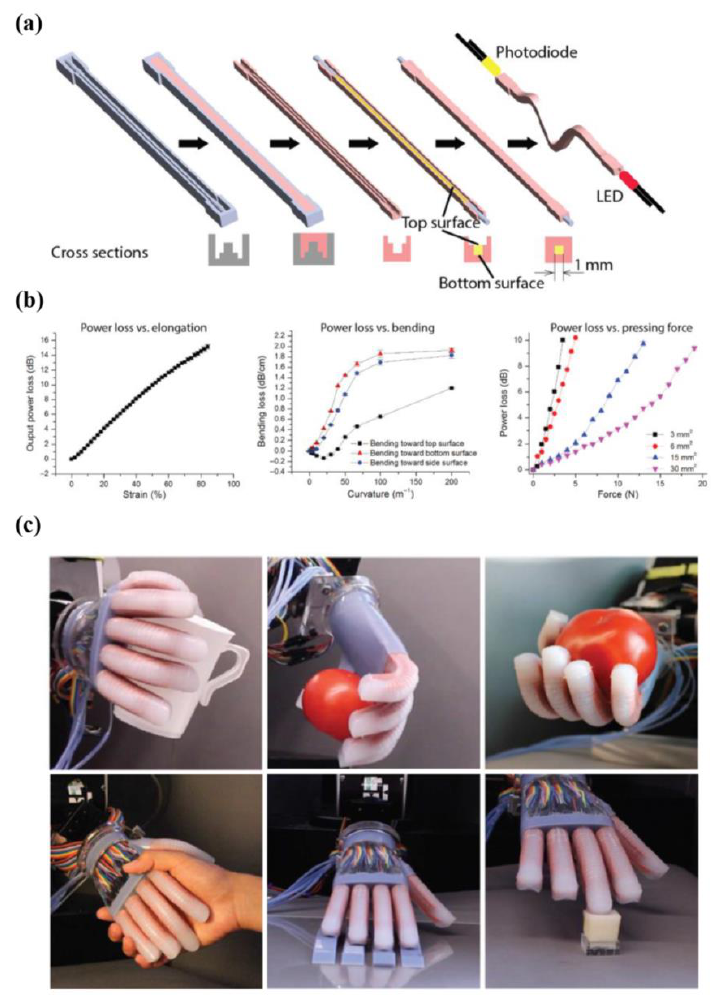
Figure 17. ( a ) Schematic illustration explaining fabrication process of the waveguide; ( b ) output data showing the sensing capabilities of waveguide sensor with respect to different situations including elongation, bending, and pressing force; ( c ) sensing abilities of the device related to the various motions (reprinted with permission for Figure 17a–c from Ref. [142] Copyright 2016 The American Association for the Advancement of